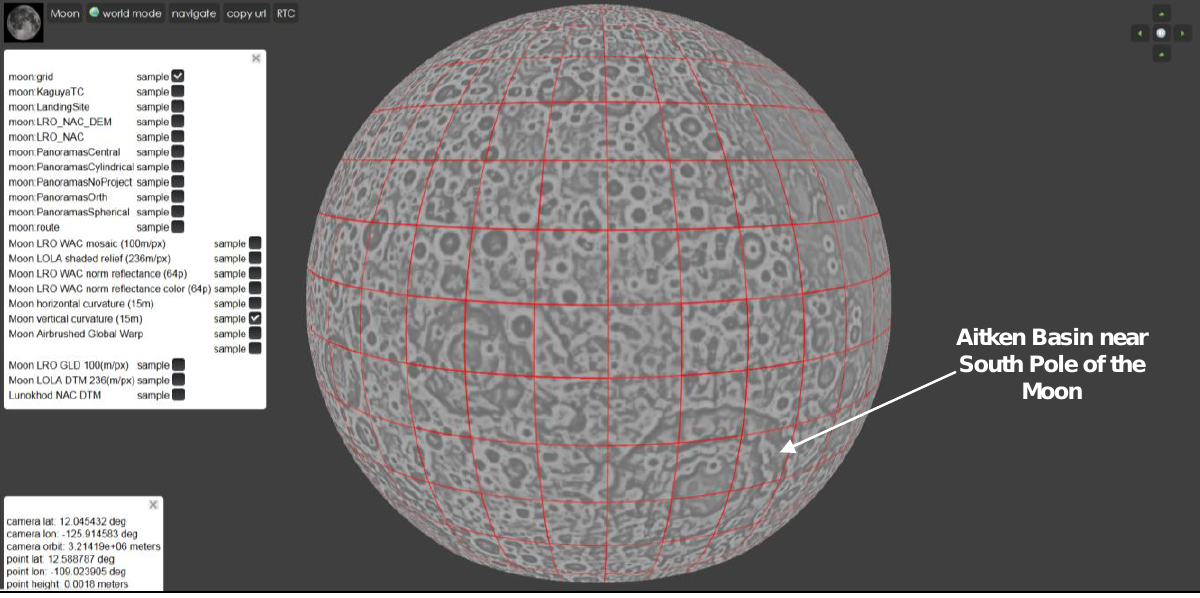
Figure 3. User interface of Virtual morphometric globe of the Moon produced using LOLA DEM (Smith et al., 2010) and demonstrated the values of vertical curvature: minimum -10 (black) and maximum +10